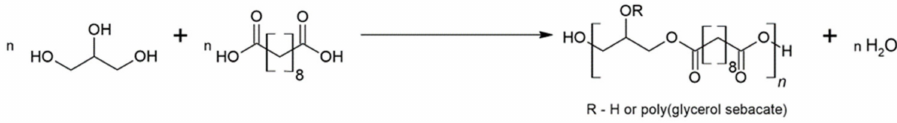
Figure 1. Polycondensation of sebacic acid with glycerol.